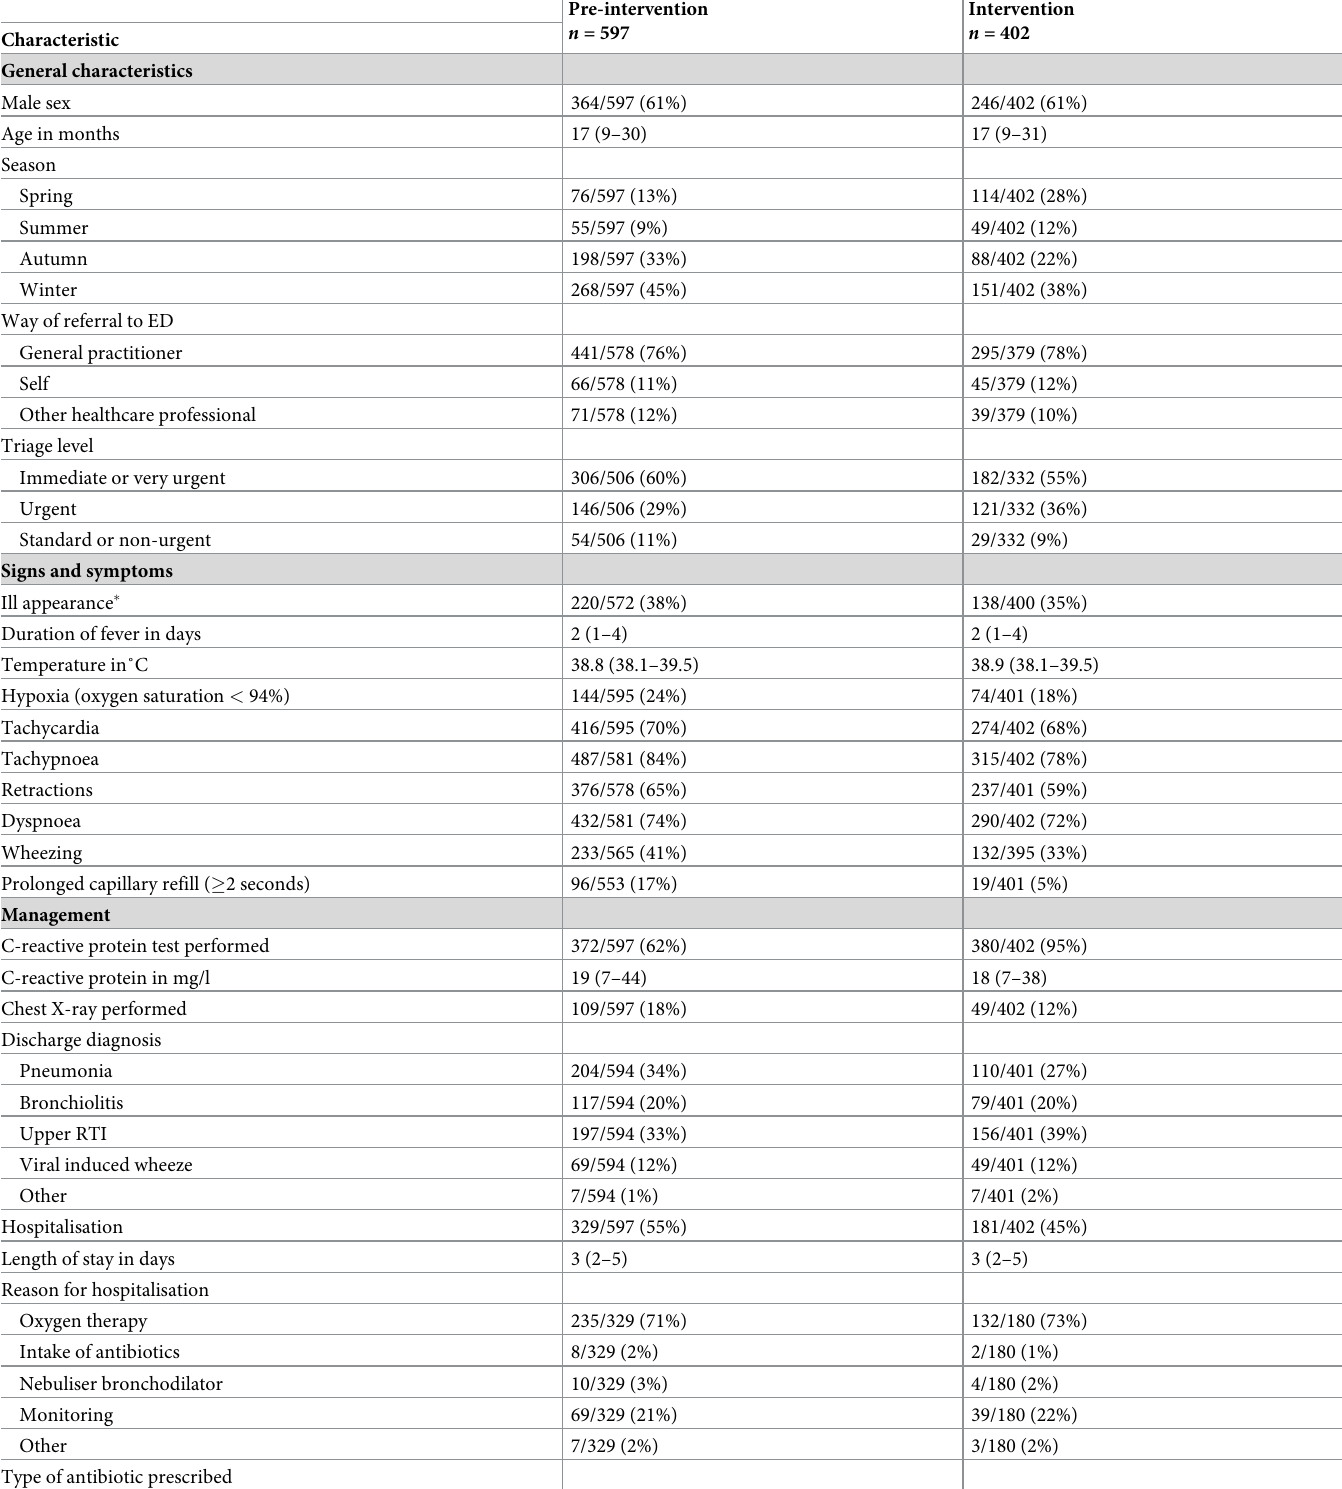
Table 1. Baseline characteristics of the study